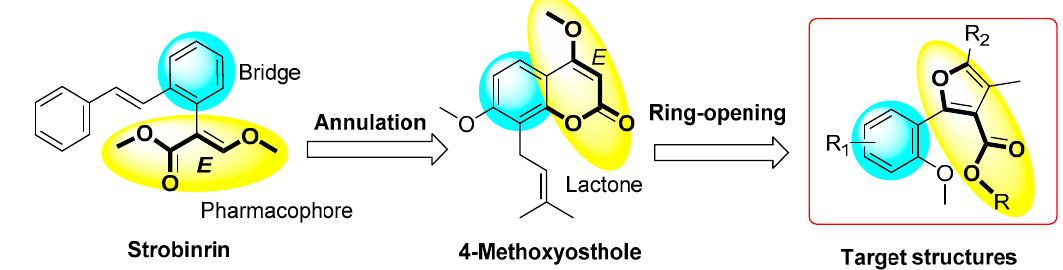
Figure 2. Design strategies of target molecules.